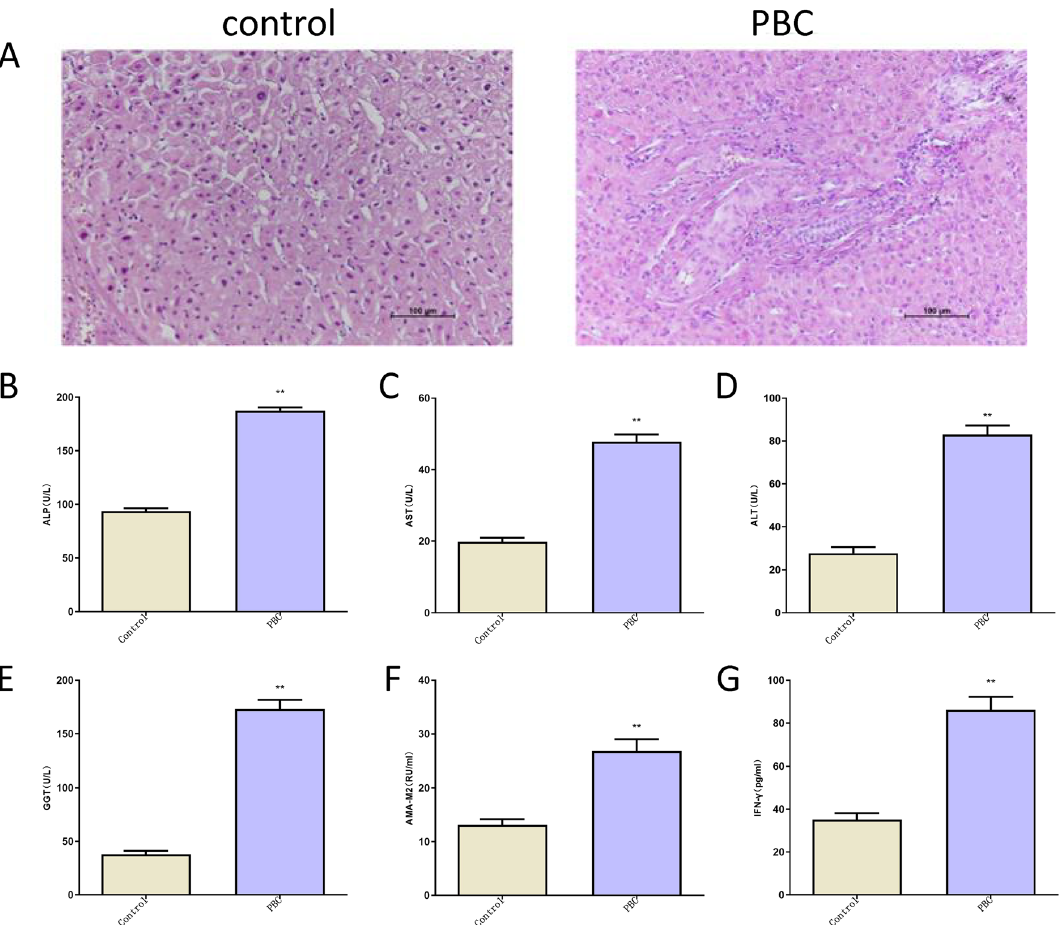
Figure 1. Histopathological and serum biochemical index analysis of PBC patients. ( A ) HE staining examination of liver tissues obtained from PBC subjects and healthy volunteers. ( B–G ) The levels of ALP, AST, ALT, GGT, AMA-M2, and IFN-γ in samples of PBC patients’ sera (n = 10) and healthy volunteers (n = 10) were measured by ELISA